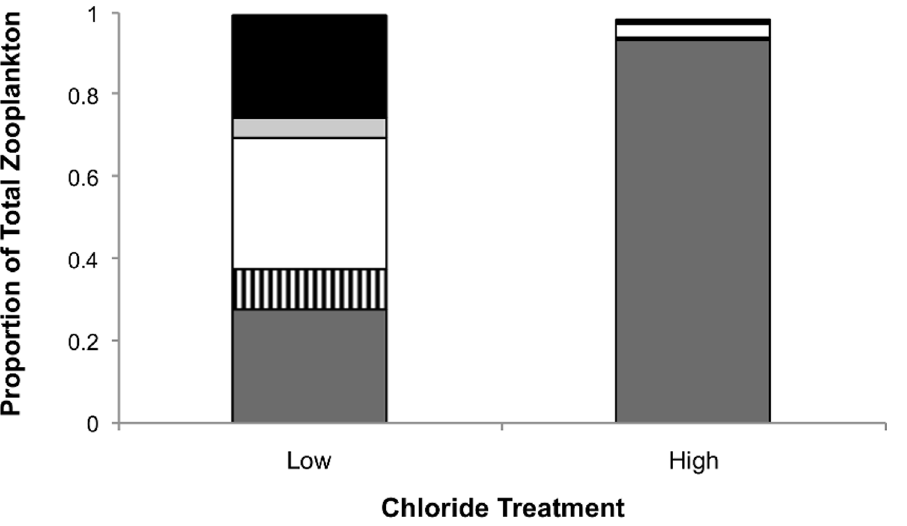
Figure 2. Zooplankton class or family as a proportion of total count across high and low chloride treatments. Dark gray bars represent the rotifer family Branchionidae, striped bars represent all other rotifers, open bars represent copepods, light gray bars represent ostracods and black bars represent cladocerans.